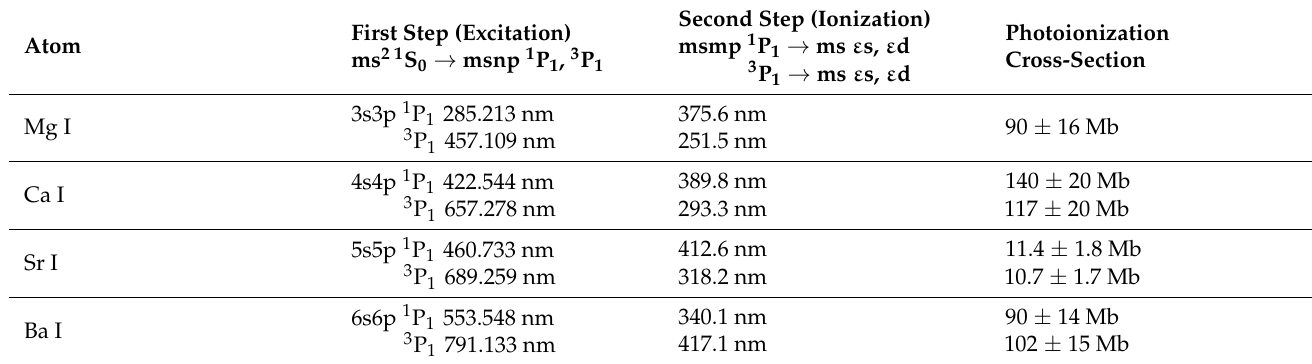
Table 7. Measured values of photoionization cross-sections for the resonance and inter-combination transitions in alkaline earth